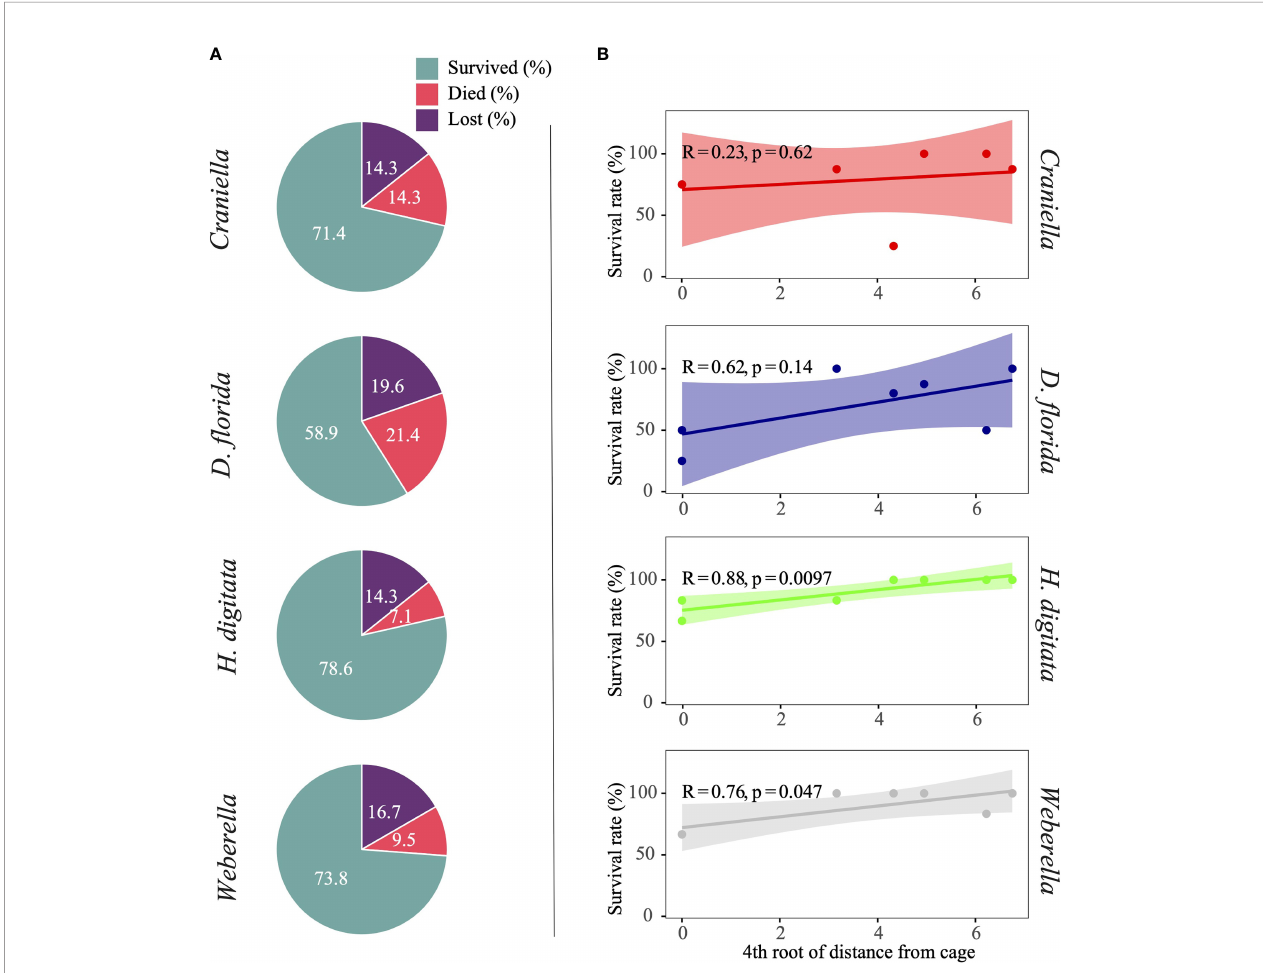
FIGURE 2 | Pie chart (A) of specimens per benthic taxa that either survived, died or are suspected lost, and scatter plot (B) with regression line and interval of con fi dence (shaded area) of survival rate (excluding lost specimens) across the 4 th root of distance from the